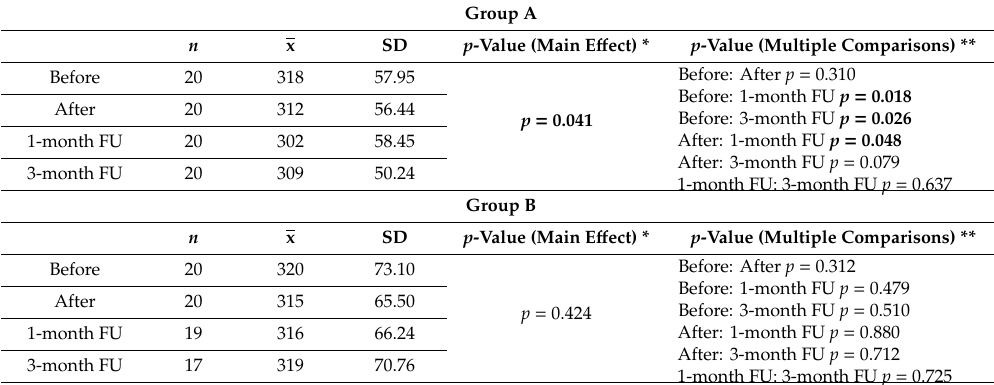
Table 3. Results of the total sway path (TSP) with closed eyes in both groups (mm). Group A n x SD p -Value (Main E ff ect) * p -Value (Multiple Comparisons)